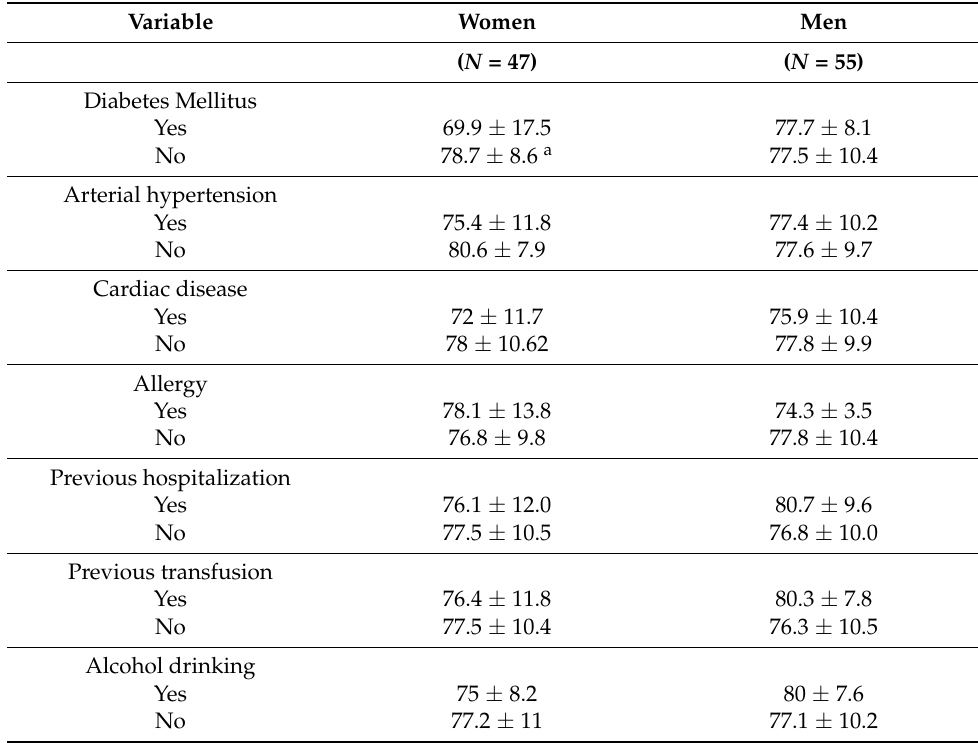
Table 6. Self-care score compared by gender for the studied nominal